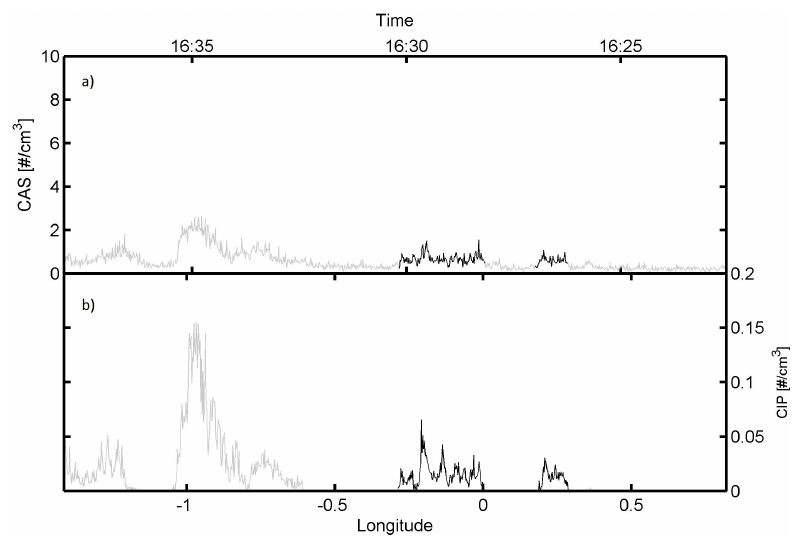
Fig. 10. Time series (from right to left) of CIP-GS and CAS number concentration for Run 2 (passing under orbits, mean tempera- ture =− 54.6°C). Contrail passes are indicated by the black data points (aircraft is flying from east to west), along with typical CIP-GS images from those times.